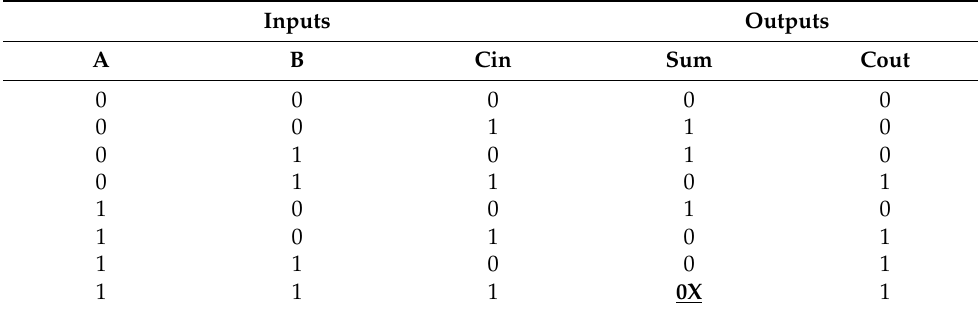
Figure 3. Current-mode logic 8T approximate adder. Table 2. Current-mode logic 8T AA truth table.